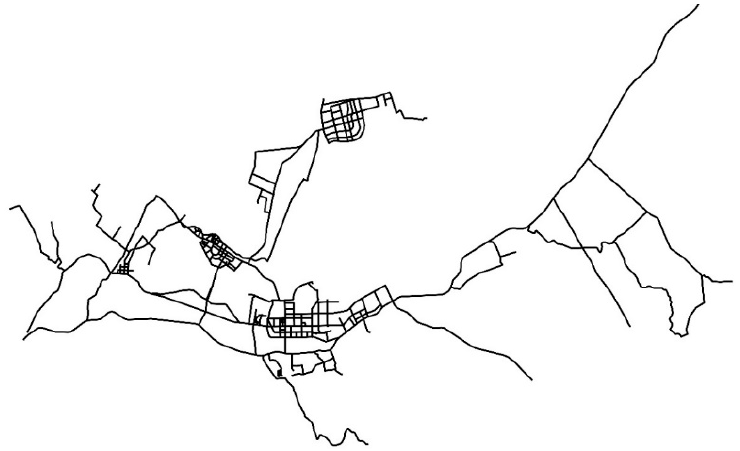
Figure 7. Schematic diagram of Qitaihe road network.